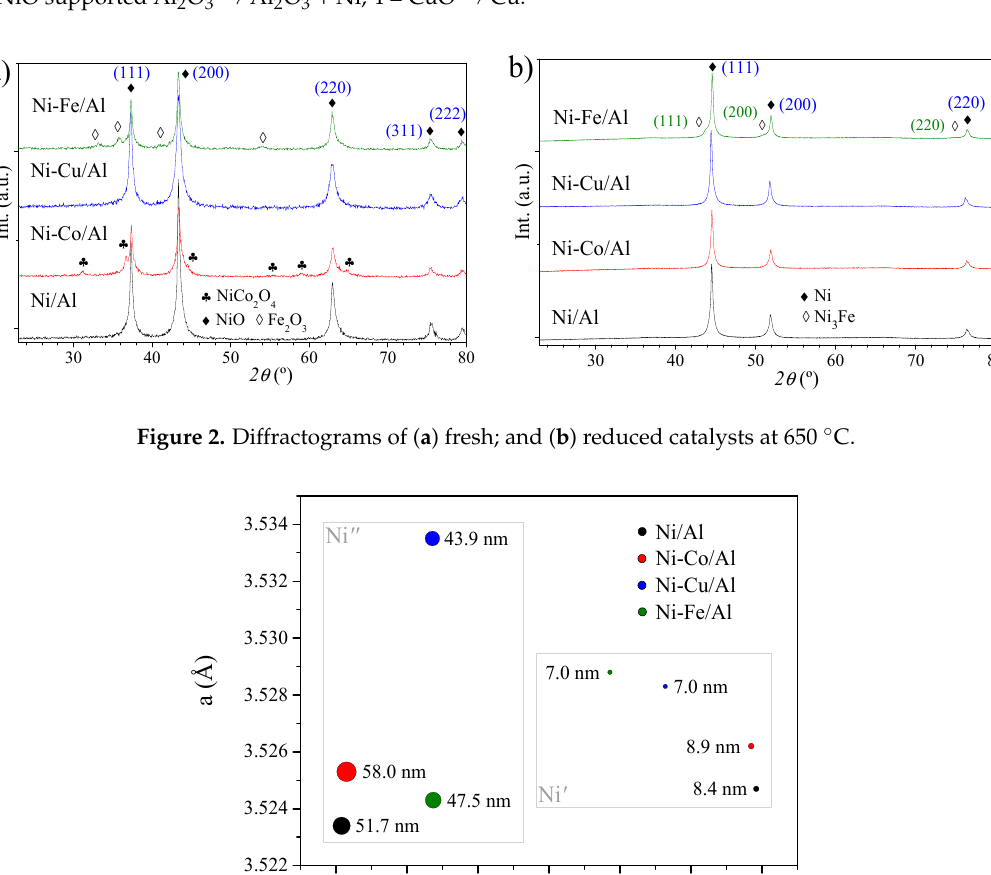
Figure 1. Catalyst temperature-programmed reduction (TPR) profiles. 1 = Bulk NiO → Ni; 2 and 3 = NiO supported Al 2 O 3 → Al 2 O 3 + Ni; 4 = CuO → Cu.